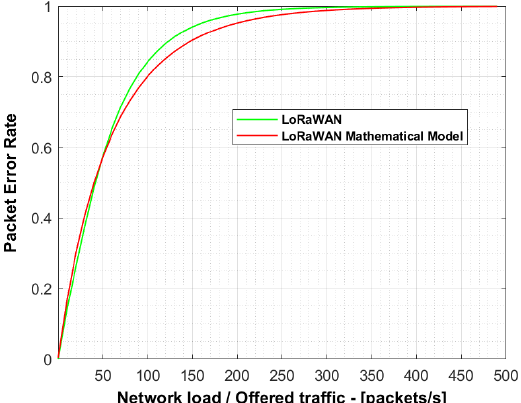
Figure 8. Comparison of packet error rate (PER) for 50,000 devices between results from simulations assuming a standard LoRaWAN network and from the theoretical mathematical model. The green and red lines represent the results from simulations assuming a standard LoRaWAN network and from the aforementioned mathematical model,